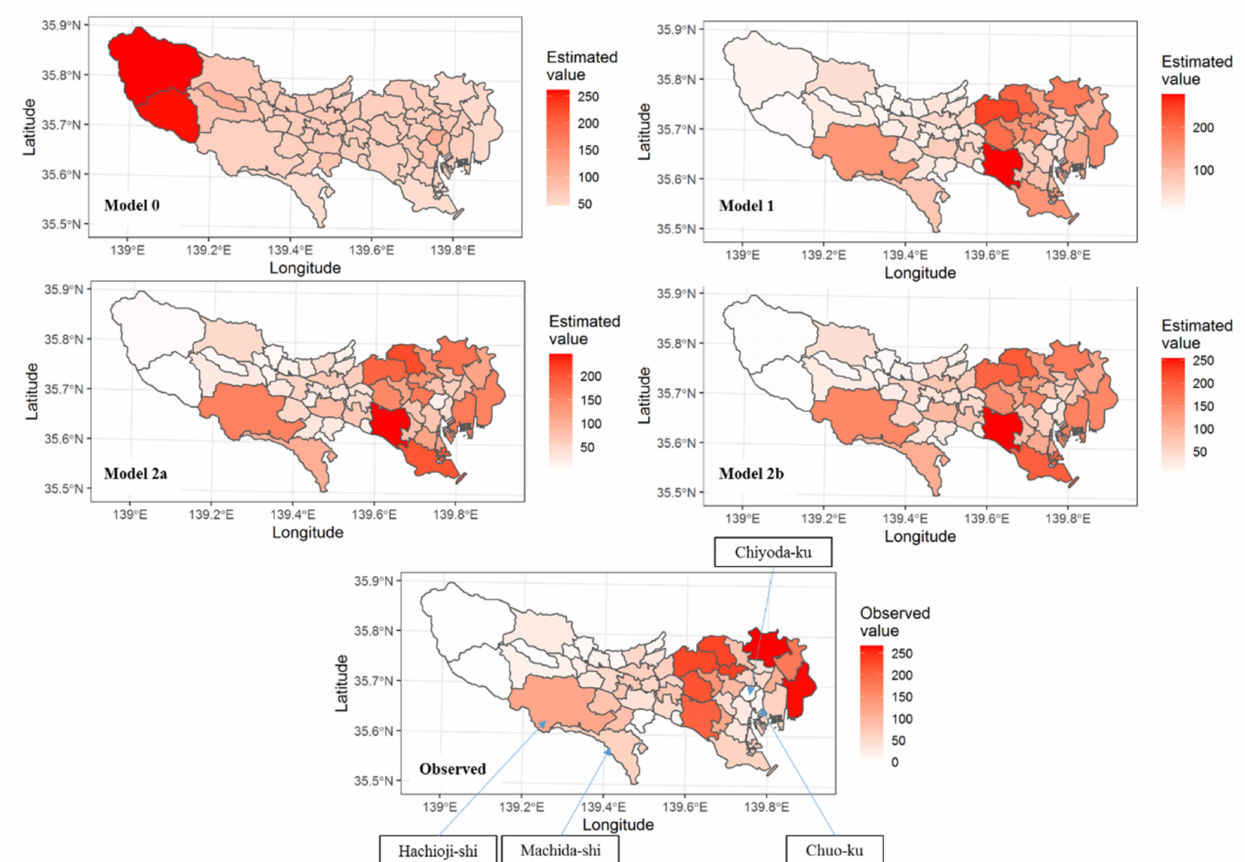
Figure 7. Estimated or observed numbers of total incoming